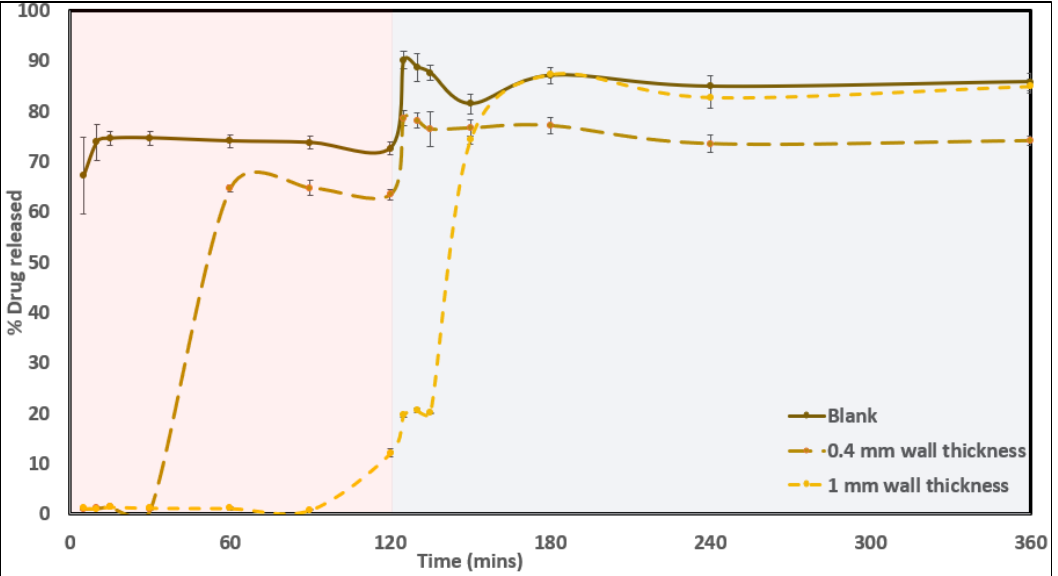
Figure 11. In vitro drug-release profile for curcumin from pure SNEDDS, SNEDDS tablets from 1 mm and 0.4 mm wall-diameter designs.